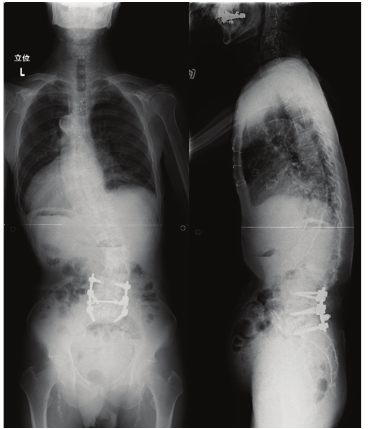
Figure 5: Postoperative radiographs showing coronal imbalance and pelvic retroversion that improved after